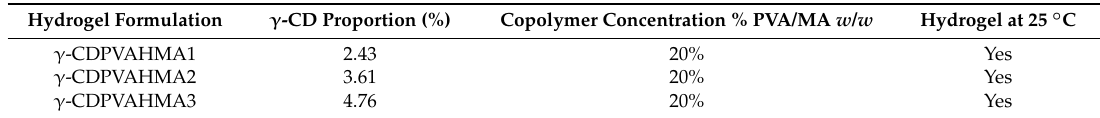
Table 2. Components of the formulations of γ